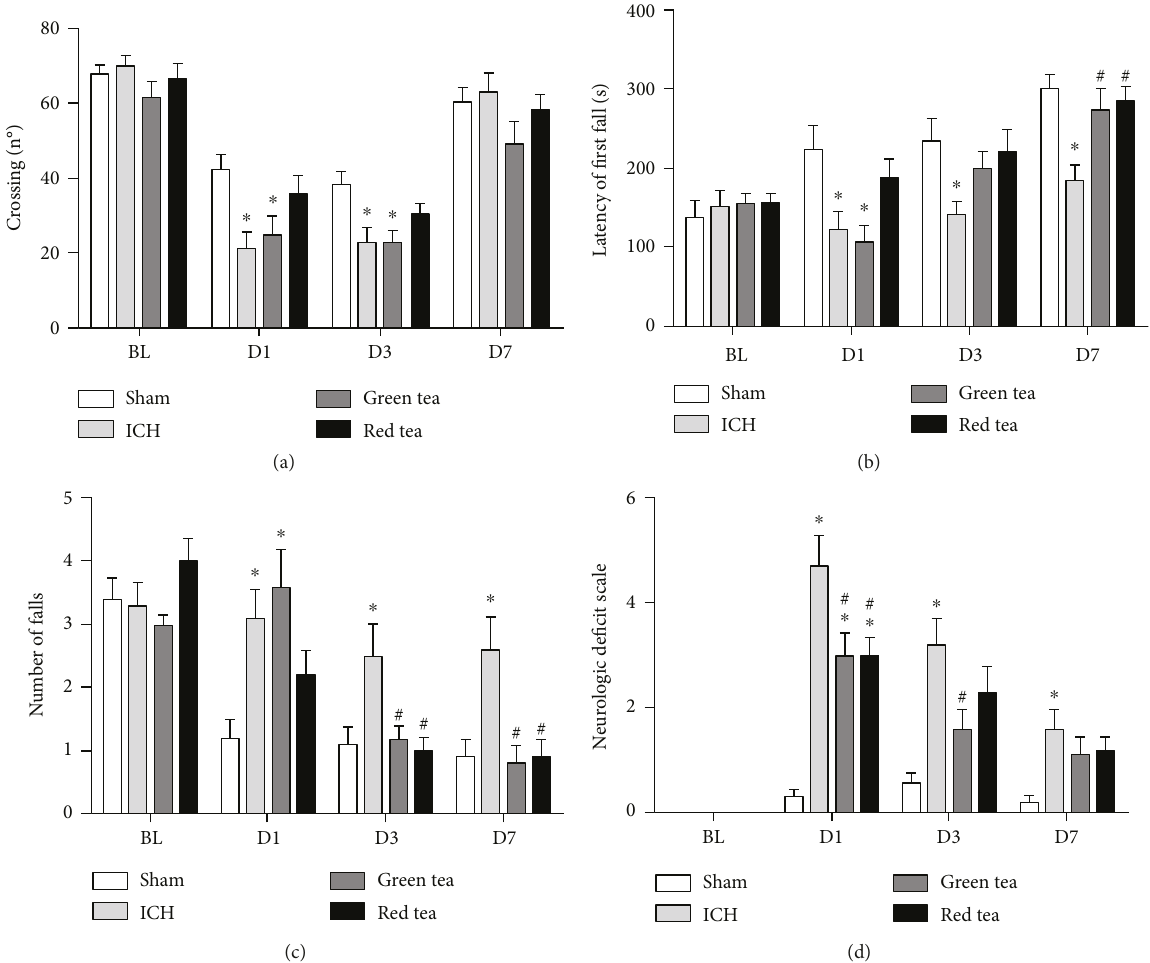
Figure 2: E ff ects of green and red tea administration on neuromotor function after ICH in rats. (a) Open fi eld test: number of crossings; (b) rotarod test: latency to the fi rst fall in seconds; (c) rotarod test: total number of falls; (d) neurological de fi cit scale: total score. Data are presented as the mean ± S.E.M. One-way ANOVA ∗ P < 0 05 in comparison to sham group, # P < 0 05 in comparison to the ICH group ( n = 10